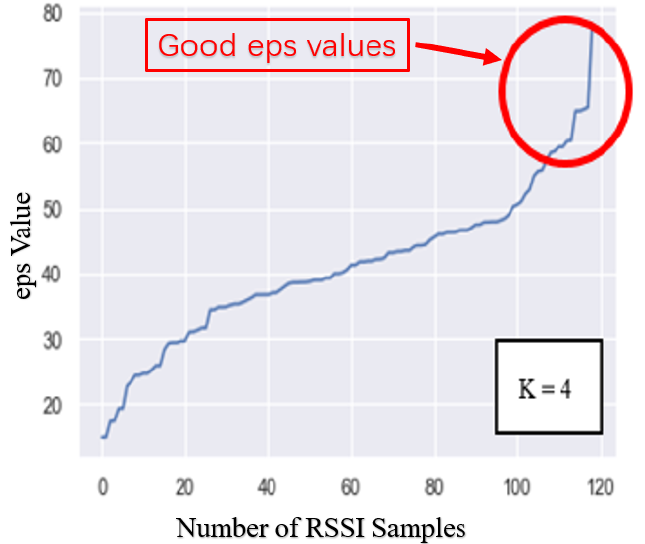
Figure 11. K-nearest neighbor distances to determine eps MinPts for CNES. The red circle represents “elbow”, which means there exist good eps values. Table 3. Simulation accuracies for different eps values (training epochs number = 1000, MinPts =